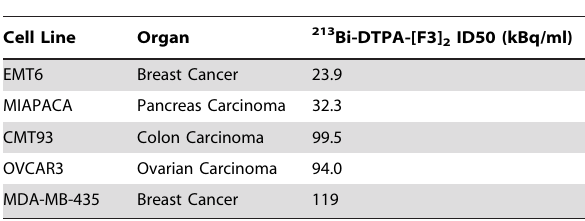
Table 1. The table shows the ID50 values of 213 Bi-DTPA-[F3] 2 , i.e. the activity concentration reducing the number of clones in a colony formation assay by 50% in different cell